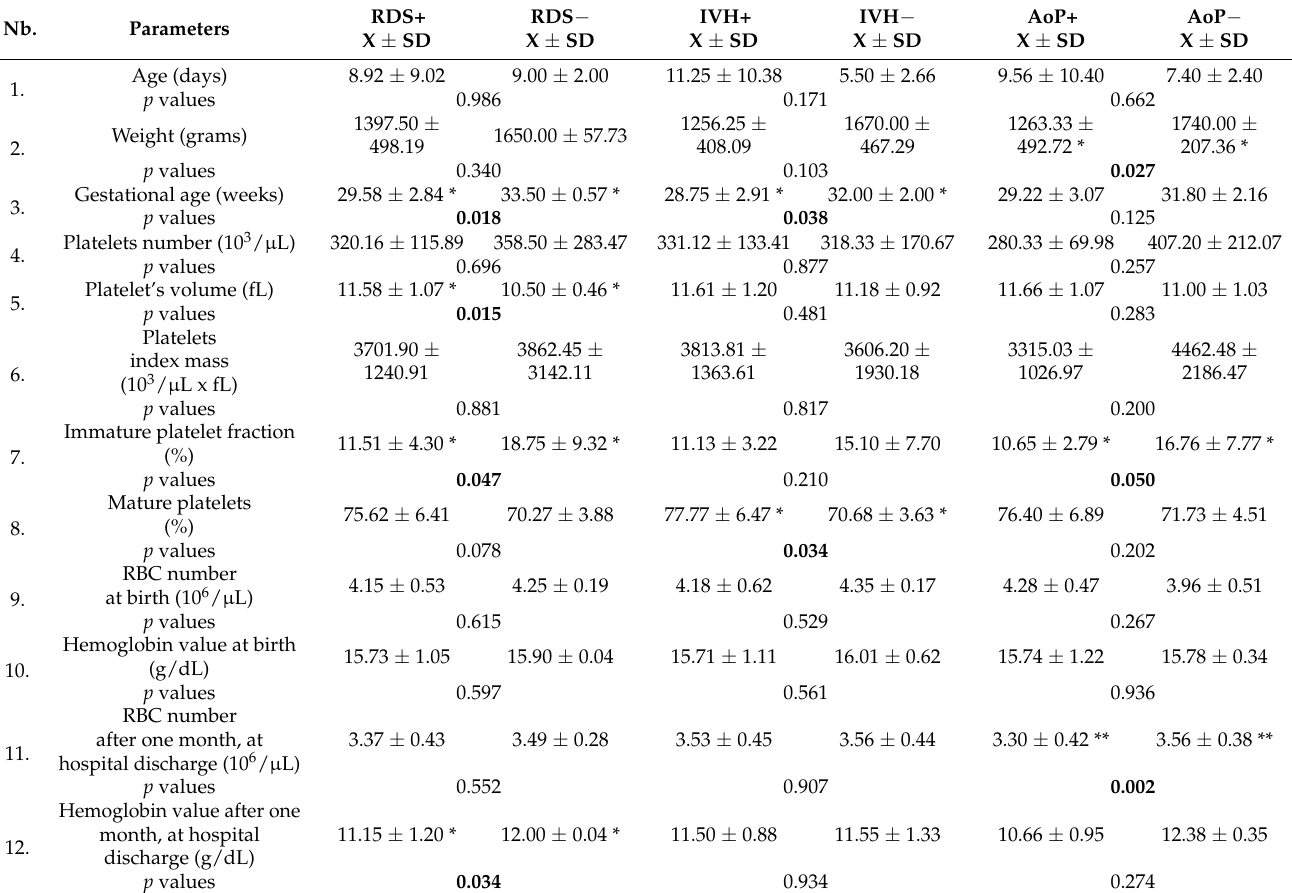
Table 3. Clinicopathological aspects and platelet parameters in preterm newborns cases.